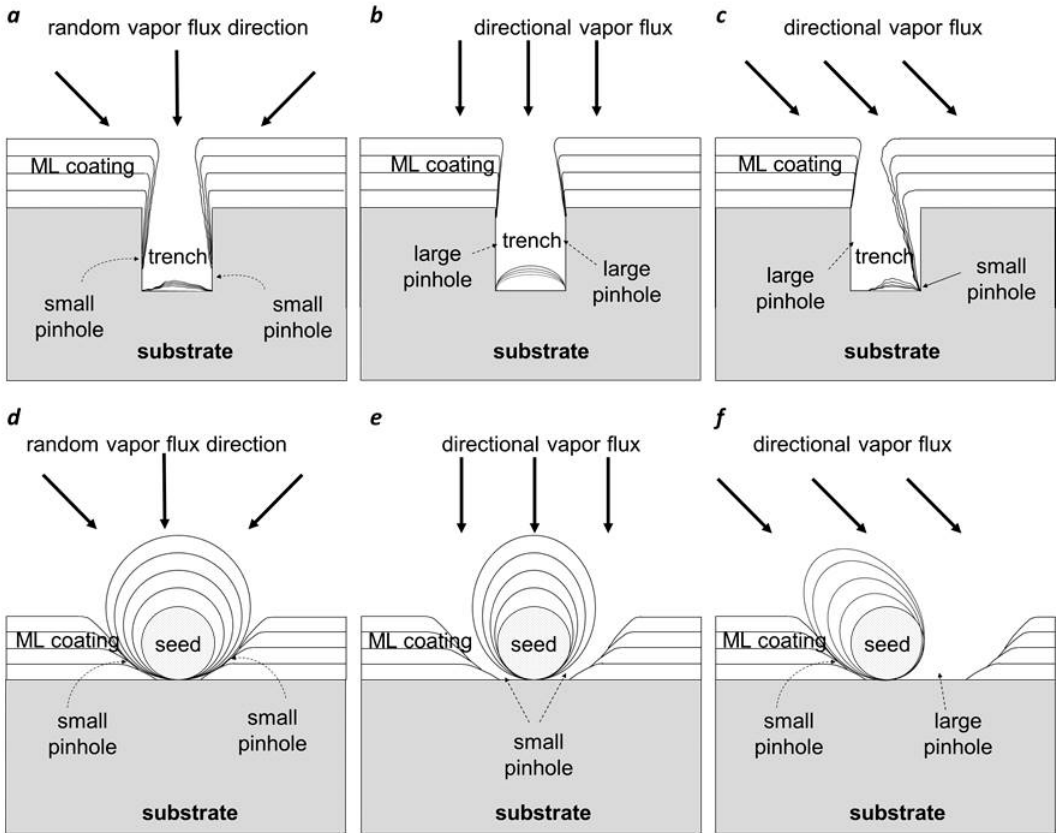
Figure 17. The schemes show the distribution of coating around two kinds of surface features (high aspect ratio trench, sphere) and formation of pinholes for a range of angles of incidence of depositing flux of atoms.